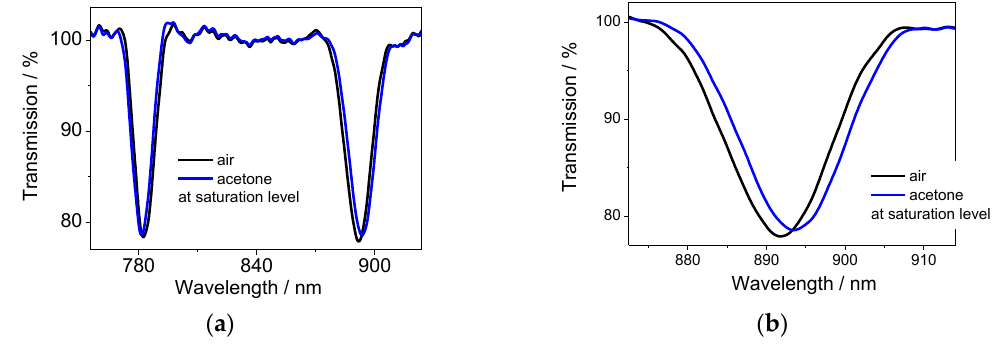
Figure 7. Transmission spectrum of ( a ) CA[4] sensor and ( b ) LPG-R in detail in air ( black ) and exposed to high concentration of acetone (close to the saturation level) ( blue ).